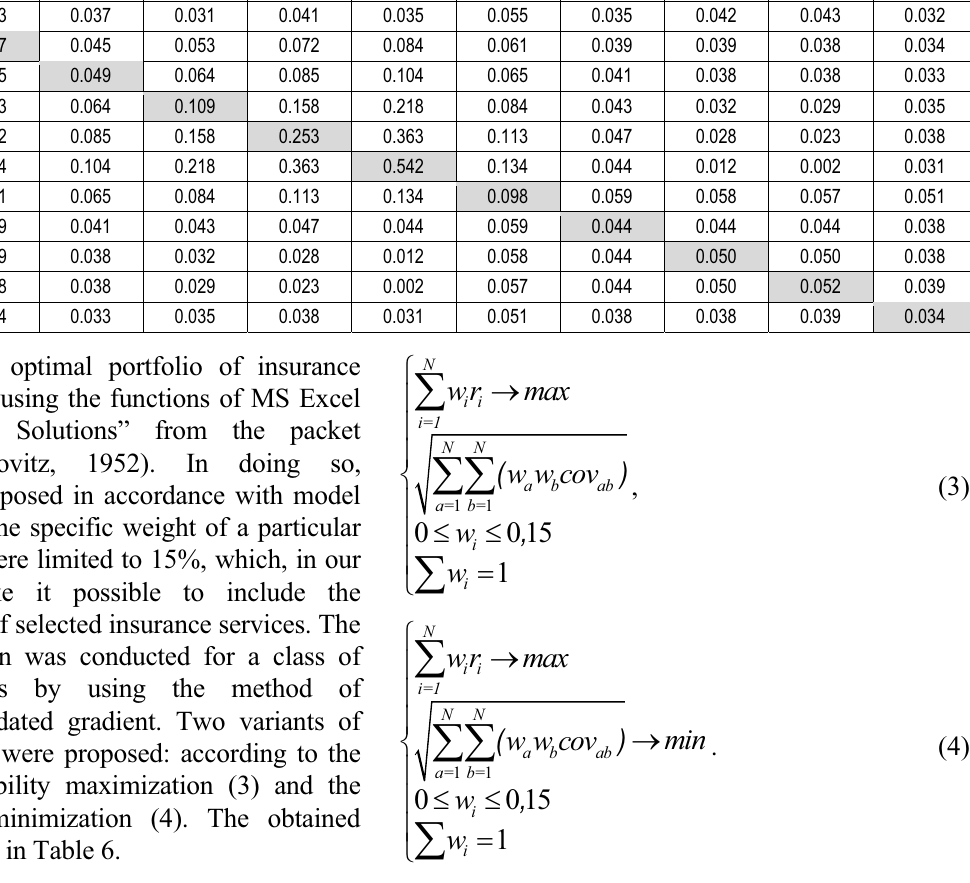
Table 6. The optimal portfolio of insurance services of the voluntary types of insurance at maximum restrictions set at 15% for the share of one type of